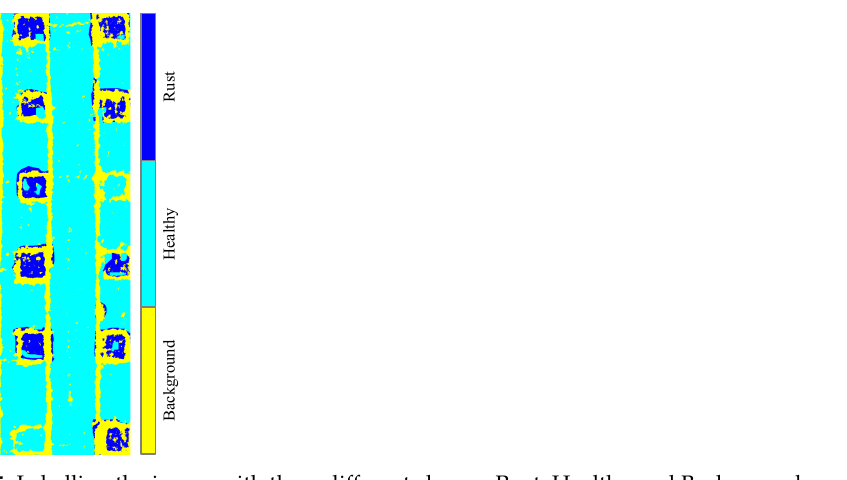
Figure 5. Labelling the image with three different classes: Rust, Healthy and